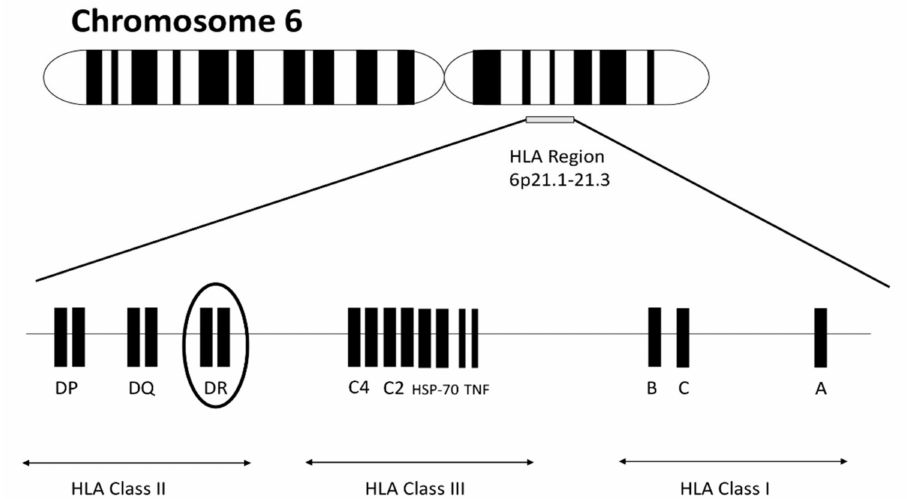
Figure 1. Human leukocyte antigen (HLA) molecules are encoded by three classes of genes located on short arm of chromosome 6 at positions 6p21.1–21.3. Within the DR subregion there is an outstandingly polymorphic HLA-DRB1 gene, which is of key importance in the pathogenesis of rheumatoid arthritis